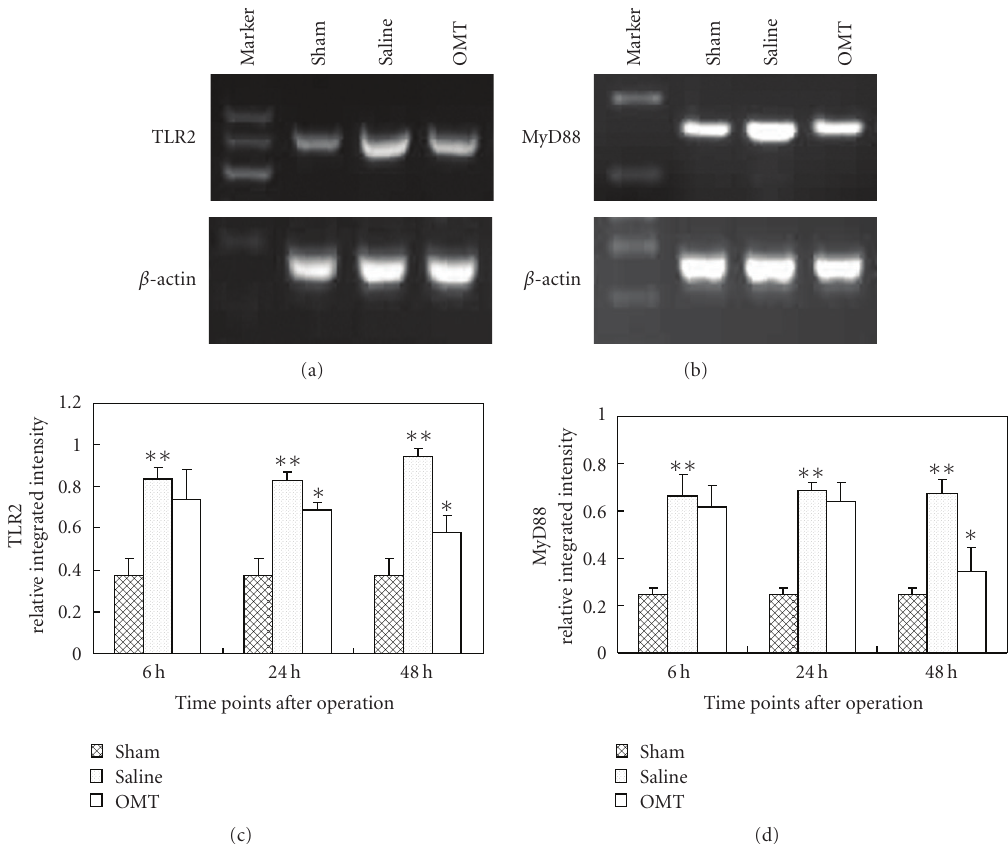
Figure 4: RT-PCR results of TLR2 and MyD88. (a) RT-PCR of TLR2 at 24 hours after the operation in each group: expression of TLR2 mRNA was evidently higher in the saline group compared with that in the OMT treatment group, and the di ff erence was significant ( P < . 05). (b) RT-PCR of MyD88 at 48 hours after the operation in each group: expression of MyD88 mRNA was similar to that of TLR2 mRNA. (c) RT-PCR of TLR2 at all time points: expression of TLR2 mRNA was evidently higher in the saline group at 6 hours and lasted up to 48 hours. There was no di ff erence between saline and OMT group at 6 hours. Compared with the saline group at 24 hours and 48 hours, expression of TLR2 mRNA was lower in the OMT treatment group, and the di ff erence was significant ∗∗ P < . 05 compared with Sham and ∗ P < . 05 compared with saline group. (d) RT-PCR of MyD88 at all time points: expression of mRNA was similar to that of TLR2 mRNA. ∗∗ P < . 05 compared with Sham and ∗ P < . 05 compared with saline